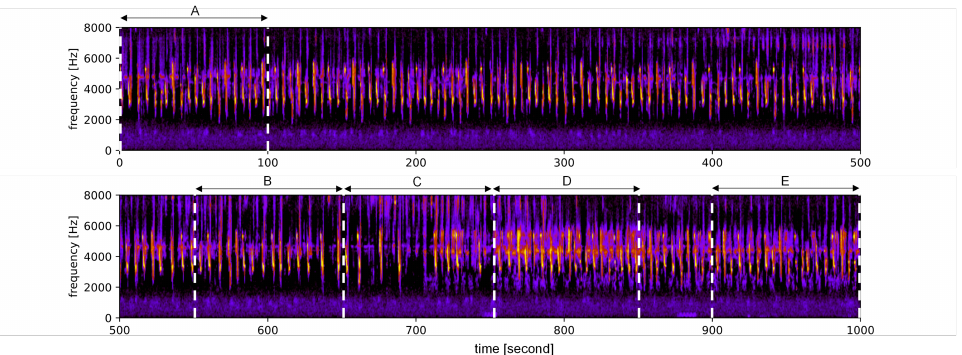
Figure 5. A spectrogram of the whole recording and 5 time slots on which we focus in the